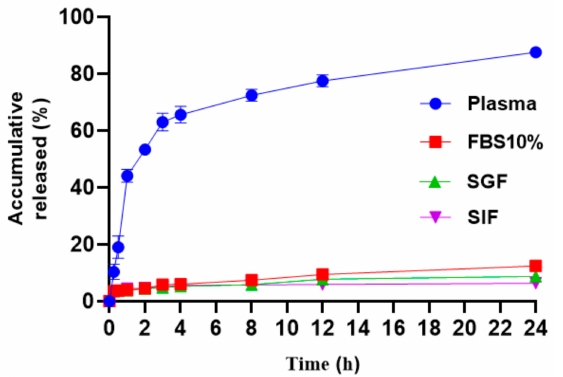
Figure 2. TP-CSO release profiles in mouse plasma, 10% FBS of cell culture medium, SGF (simulated gastric fluid, pH 1.2), and SIF (simulated intestinal fluid, pH 7.5) (n = 3).